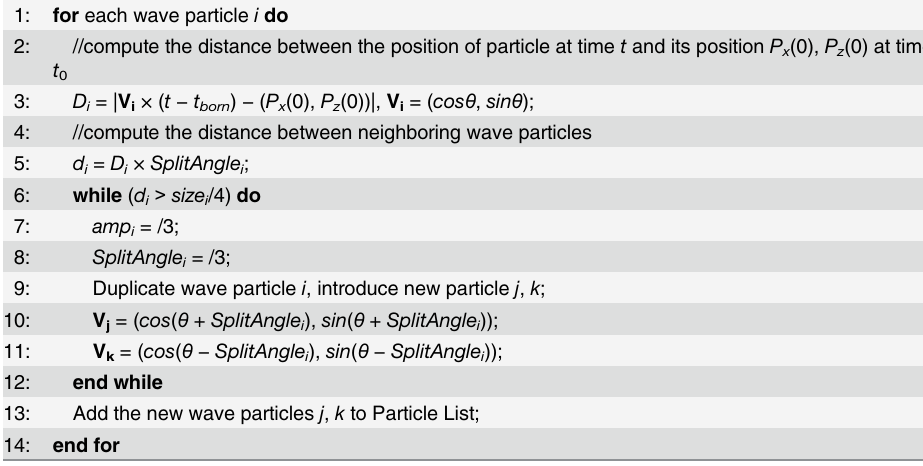
PLOS ONE | DOI:10.1371/journal.pone.0147123 January 25,